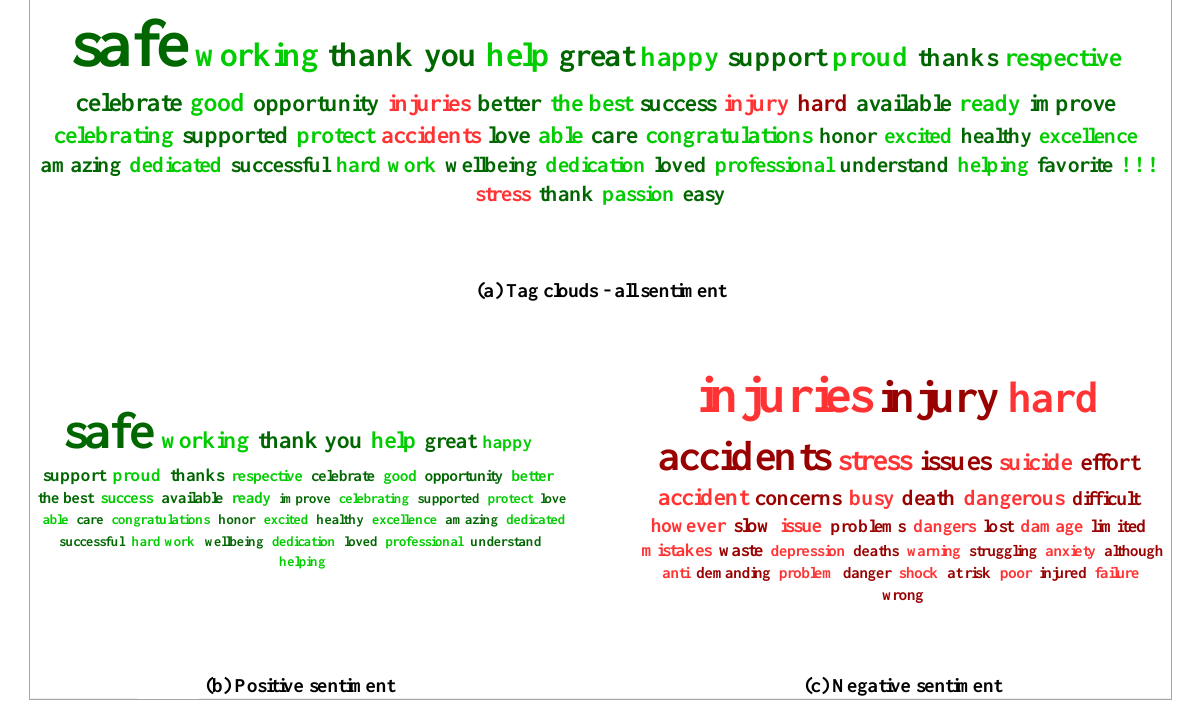
Figure 6. Average number of words per item of text and percentage containing a URL or email address.